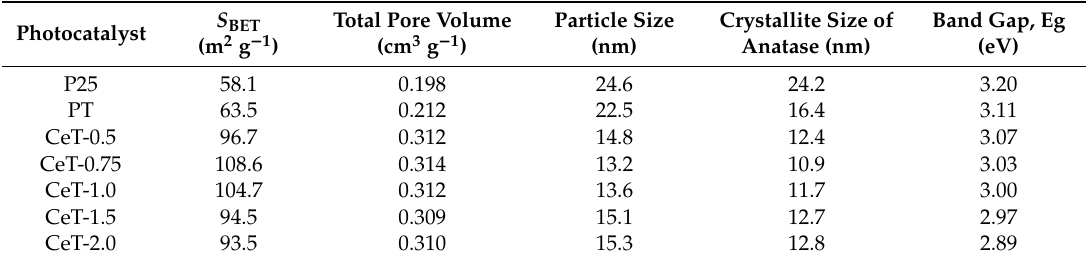
Table 1. Properties of Degussa P25 TiO 2 (P25), pure TiO 2 (PT), and Ce-doped TiO 2 catalysts